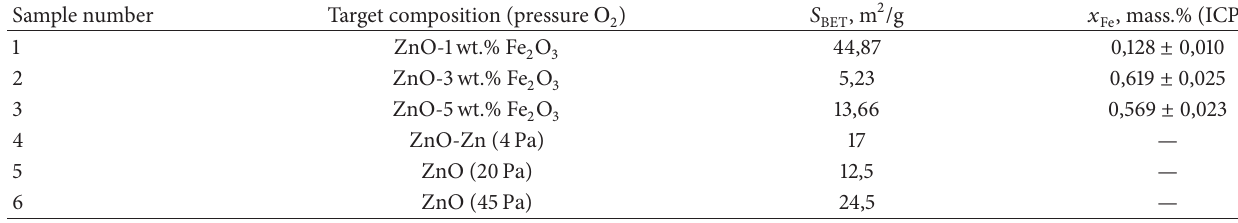
Table 1: Specific surface area ( 𝑆 BET ) and the iron concentration ( 𝑥 Fe ) in NPs.